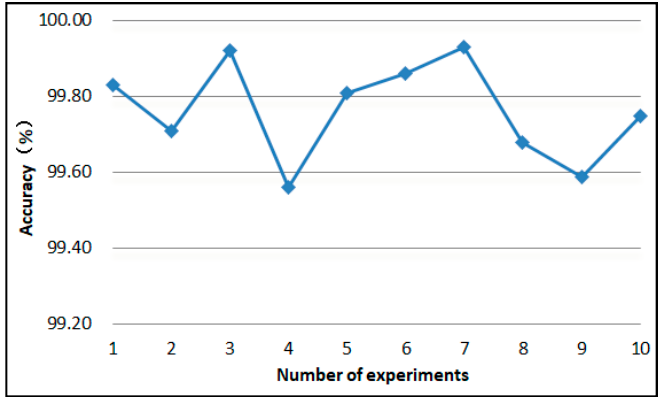
Figure 17. Accuracy of ten experiments (test set of Worm Gear Reducer).